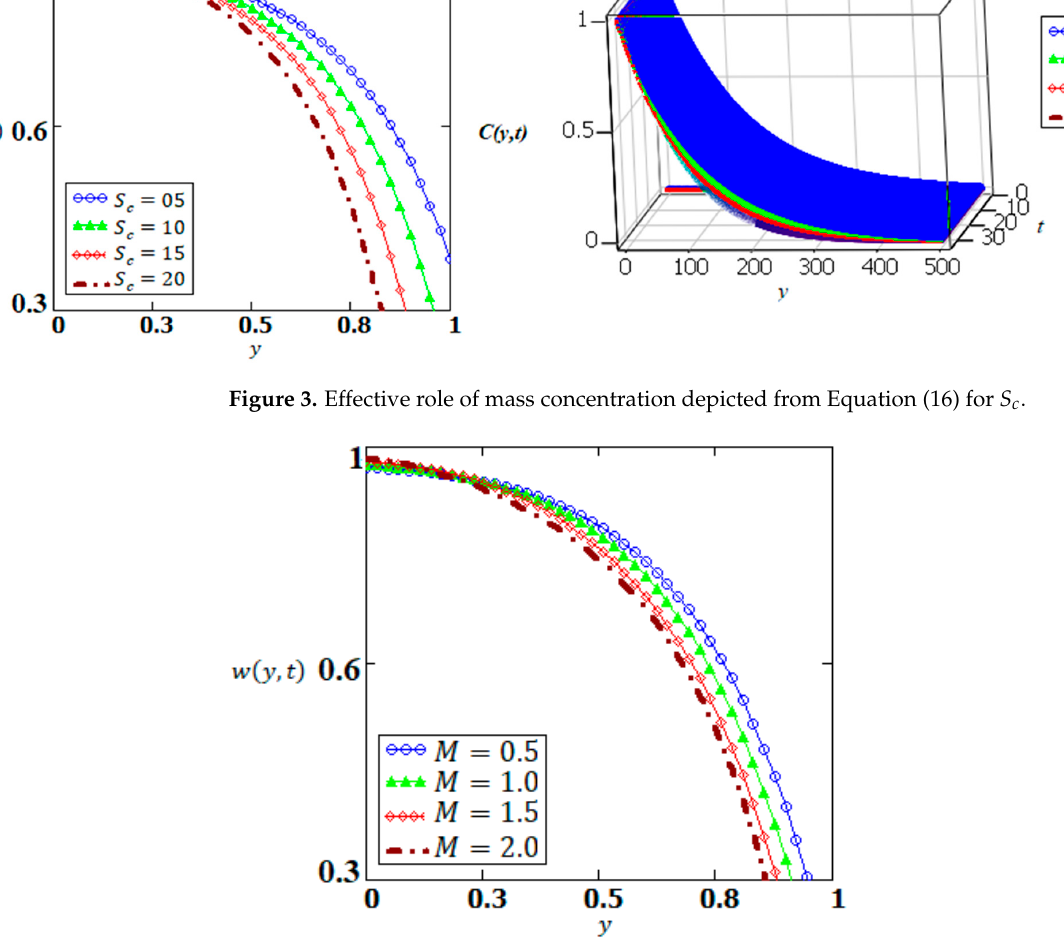
Figure 4. Effective role of velocity field depicted from Equation (19) for 𝑀 .